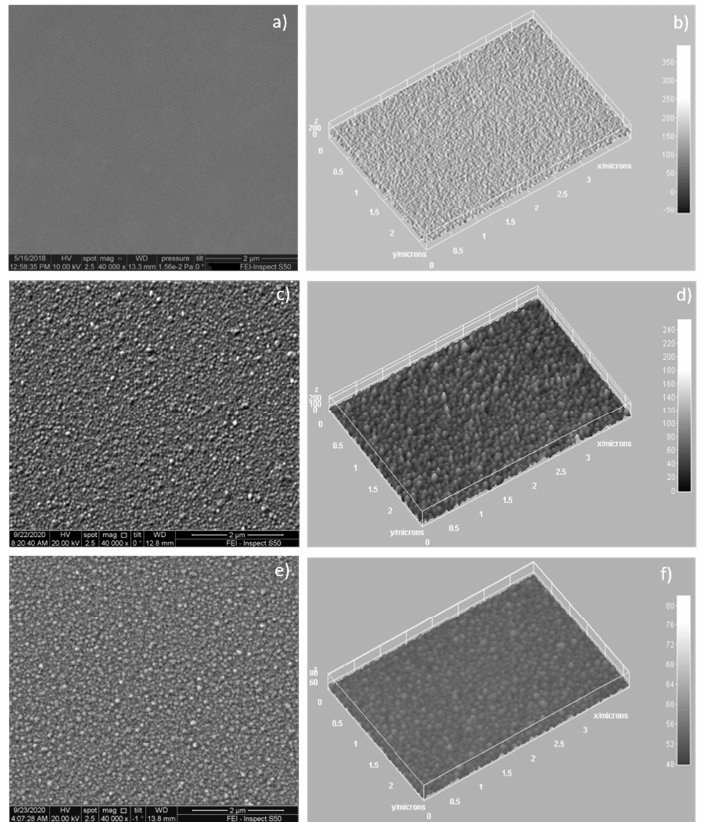
Figure 6. SEM images of HApCs coatings at: ( a ) p = 2 × 10 −3 mbarr; ( c ) p = 5 × 10 −3 mbarr; ( e ) p = 1.2 × 10 −2 mbarr; 3D images of: ( b ) Figure 6a; ( d ) Figure 6c; ( f ) Figure 6e; performed with ImageJ software.